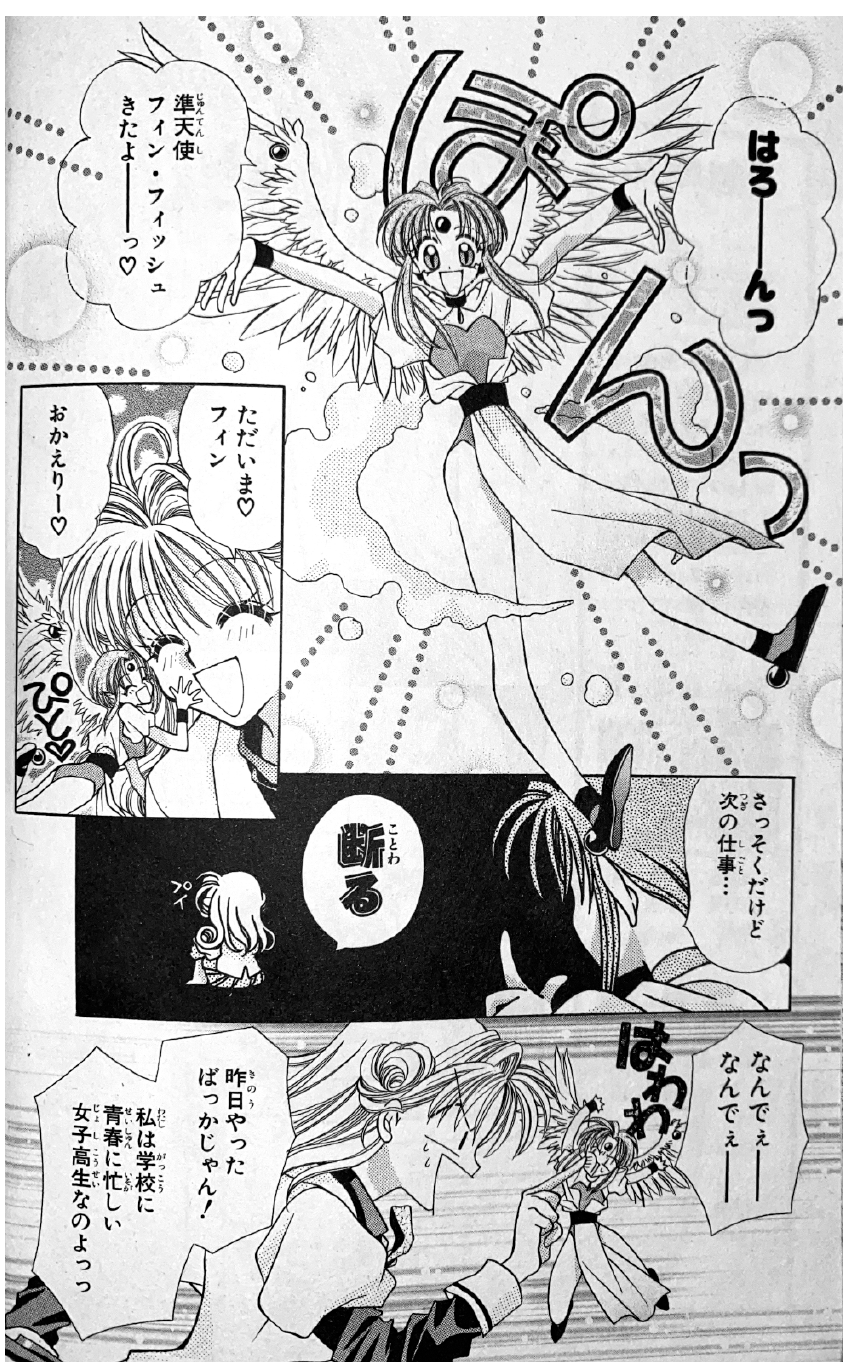
Figure 4 Image A of semi-angel Fin Fish when she first appears and is introduced as semi-angel to the reader (complete page) (Tanemura